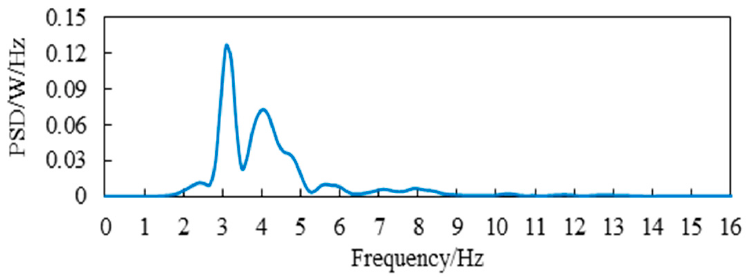
Figure 15. Power spectral density of load random term.